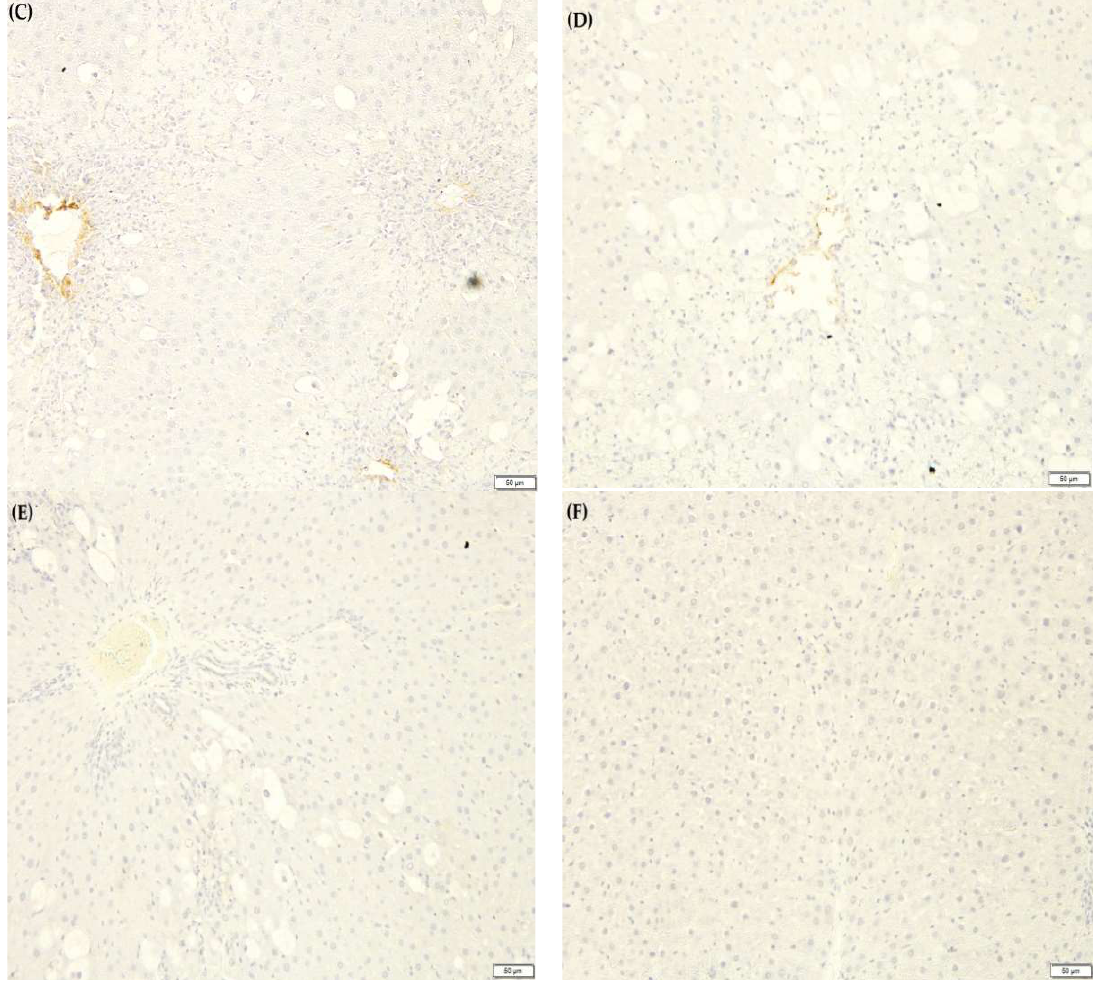
Figure 4. The effect of F. lepicarpa extract on the proinflammatory marker interleukin 6 (IL-6). Total magnifications 10×. ( A ) Control group, normal. ( B ) CCl 4 (1.0 mL/kg bwt), high expression of IL-6. ( C ) F. lepicarpa (100 mg/kg bwt + CCl 4 ), low expression of IL-6. ( D ) F. lepicarpa (200 mg/kg bwt + CCl 4 ), low expression of IL-6. ( E ) F. lepicarpa (400 mg/kg bwt + CCl 4 ), low expression of IL-6. ( F ) F. lepicarpa (400 mg/kg bwt, plant control), normal.